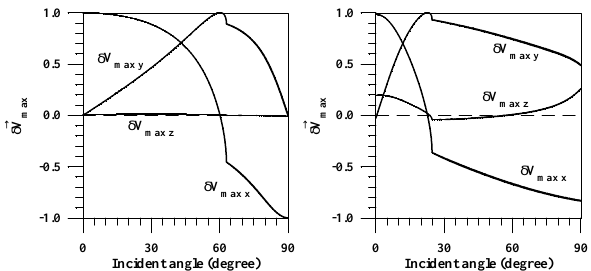
Fig. 12. Components of the unit vector along the vector of maxi- mal perturbations of velocity δ V max (for the surface wave it is the direction of the principal axis of the polarisation ellipse) versus the incident angle of the entropy wave setting the value c p . The left (right) plots show the direction of the unit vector behind the front of the fast (slow) shock wave.